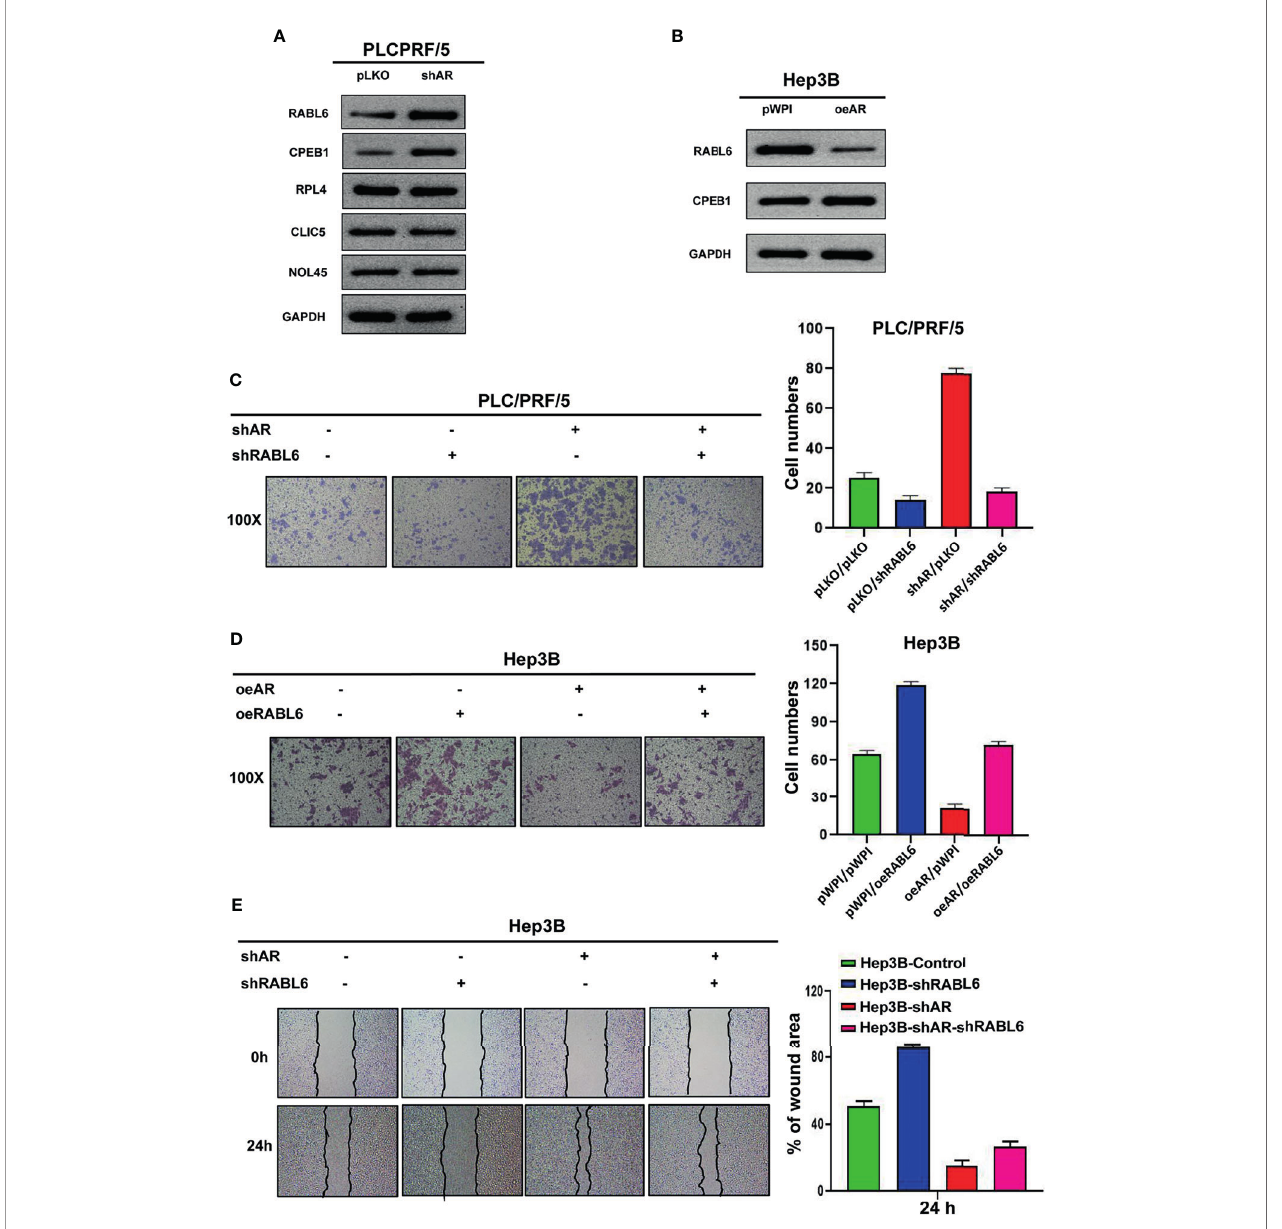
FIGURE 3 | AR/miR-122-5p axis may in fl uence HCC cells invasion and migration capacities via altering the RABL6 expression. (A, B) Western blot assay was used to check related gene protein expression after shAR/oeAR in HCC cells. (C) Transwell invasion assay was used to check HCC PLC/PRF/5 cells invasion capacity after shAR/shRABL6 in the cells. (D) Transwell invasion assay was used to check HCC Hep3B cells invasion capacity after oeAR/oeRABL6 in the cells. (E) Wound healing migration assay was used to check HCC Hep3B cells migration capacity after oeAR/oeRABL6 in the